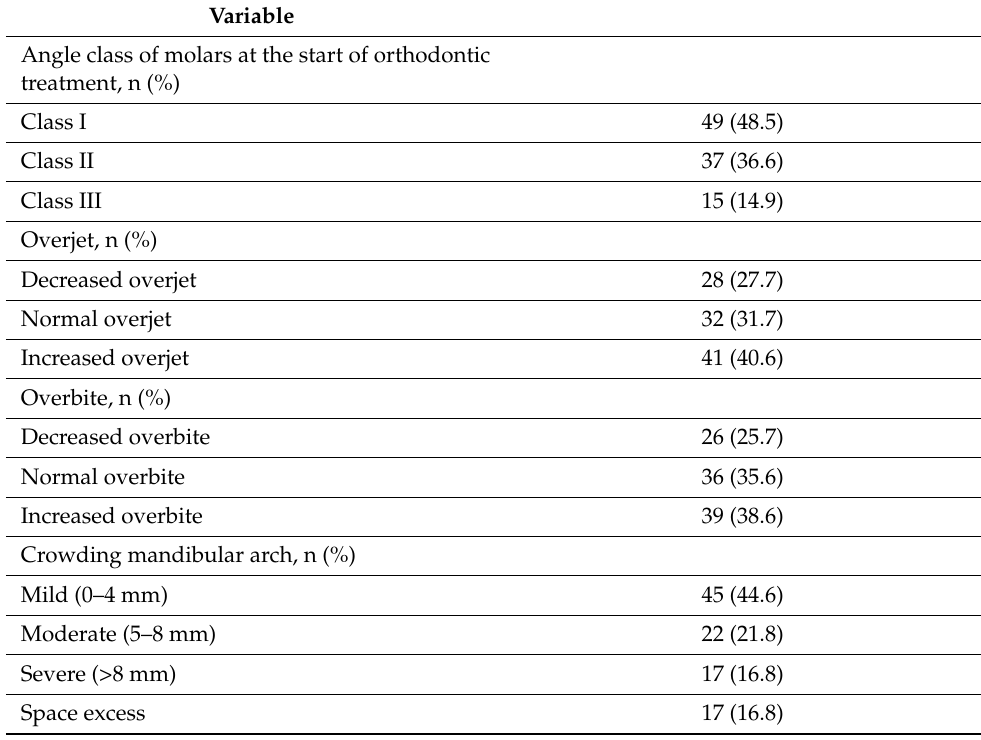
Table 2. Characteristics of included patients‘ malocclusion at baseline.